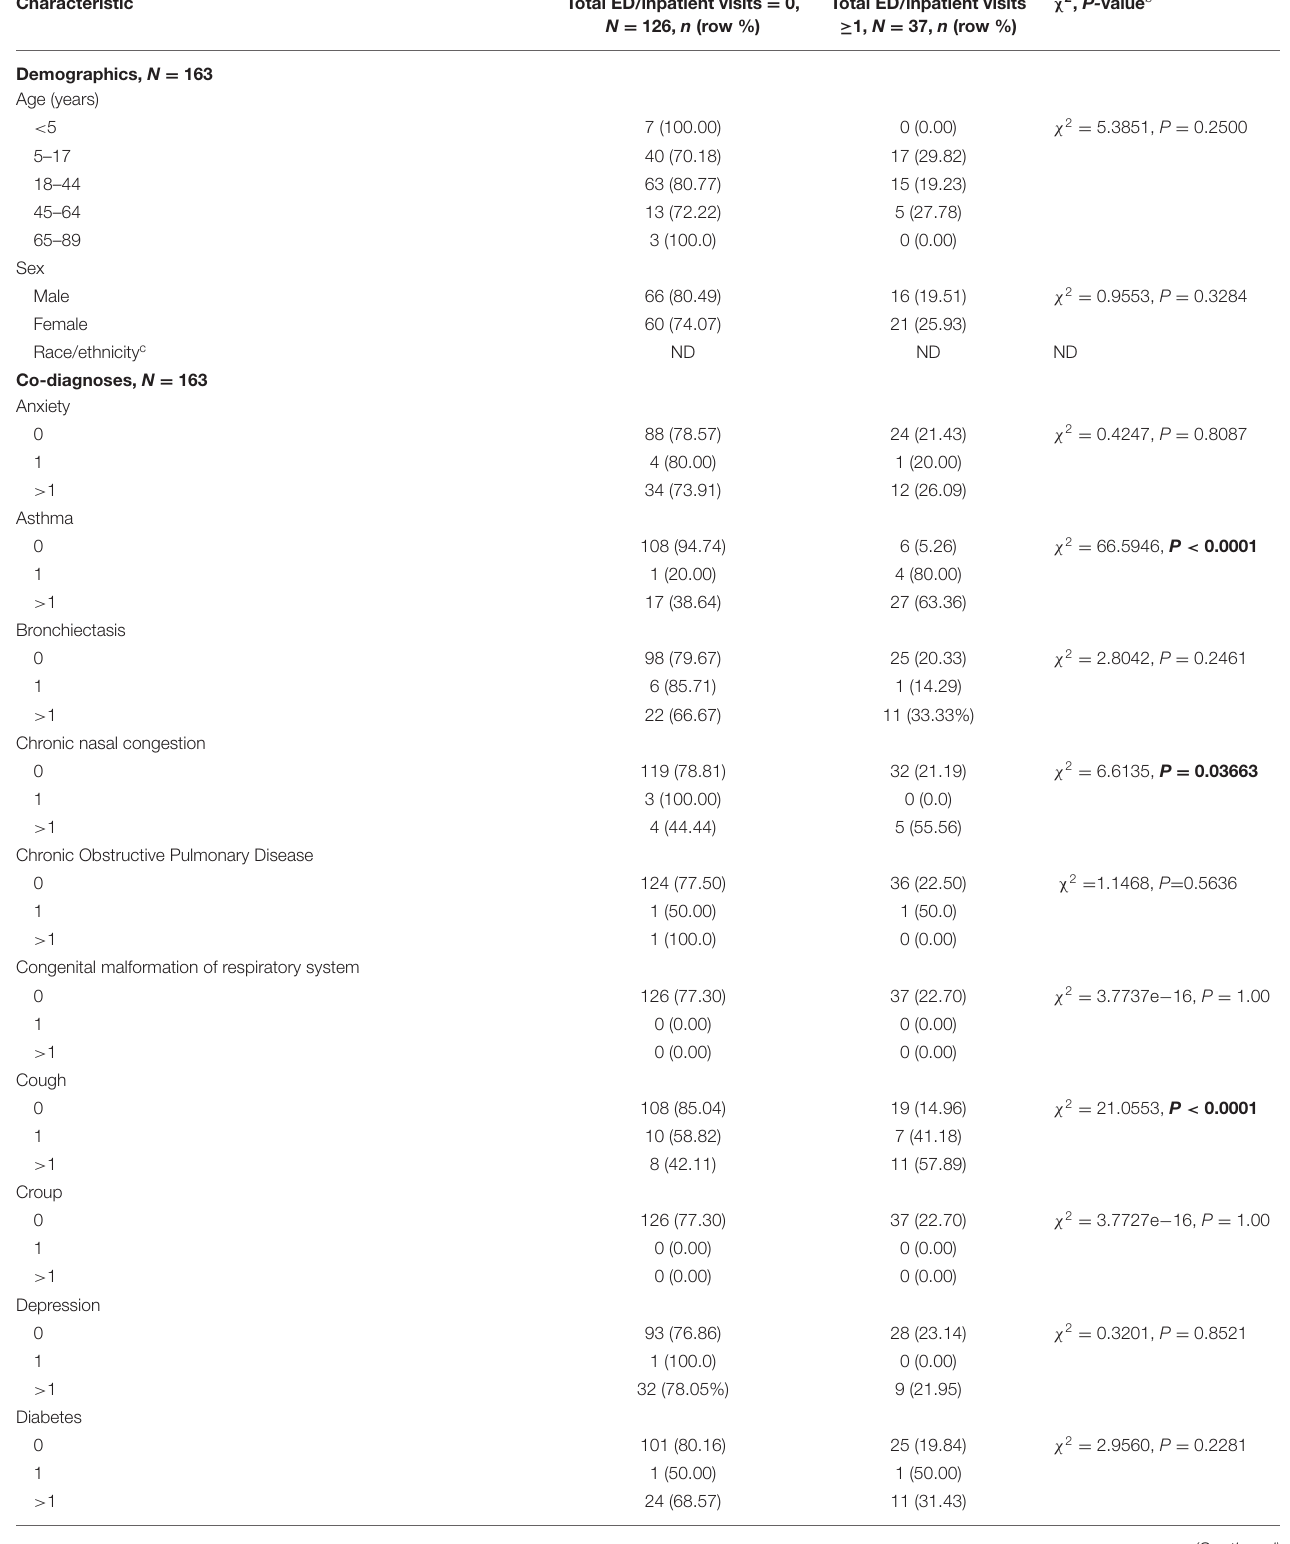
TABLE 2 | Factors influencing health outcomes among patients with CF a ( N = 163). Characteristic Total ED/inpatient visits = 0,